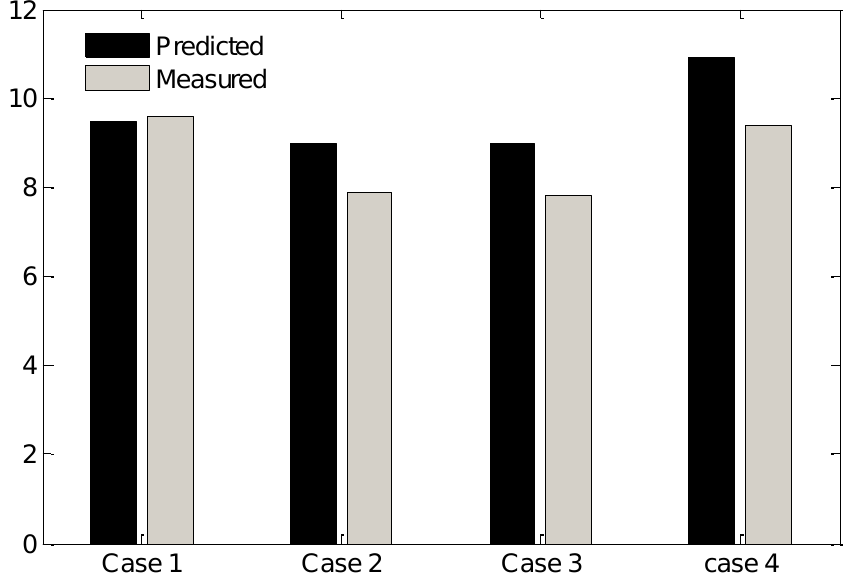
Figure 11. Predicted and measured total energy consumption of the building for each simulated